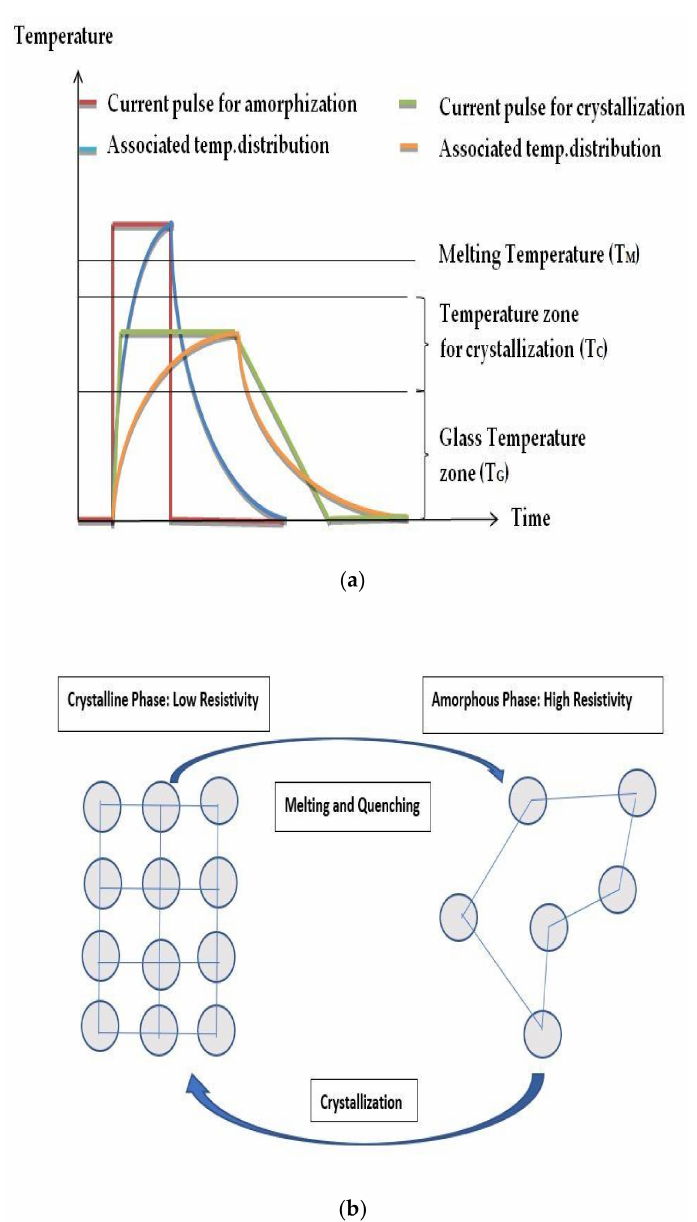
Figure 3. Illustration of the phase transition mechanisms associated with germanium telluride (GeTe) materials. ( a ) Required current pulses and resulting temperature profiles for phase change; ( b ) Crystal structure during phase